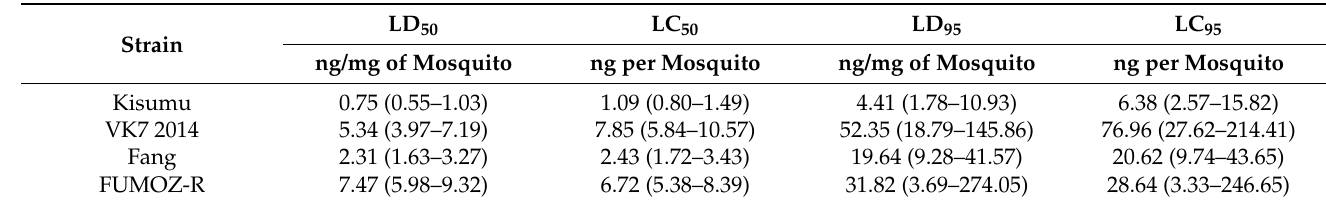
Table 2. Lethal doses and lethal concentrations in four strains of Anopheles mosquitoes by topical application of dinotefuran. 95% CI given in parentheses. Kisumu is a lab strain of Anopheles gambiae , VK7 2014 is An. coluzzii , and Fang and FUMOZ-R are An. funestus